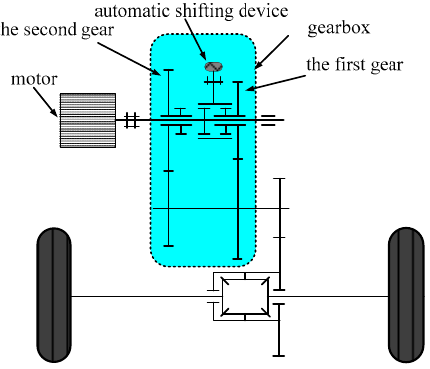
Figure 1. Structure of rear-wheel-drive electric vehicle drivetrain with motor-transmission integrated system.